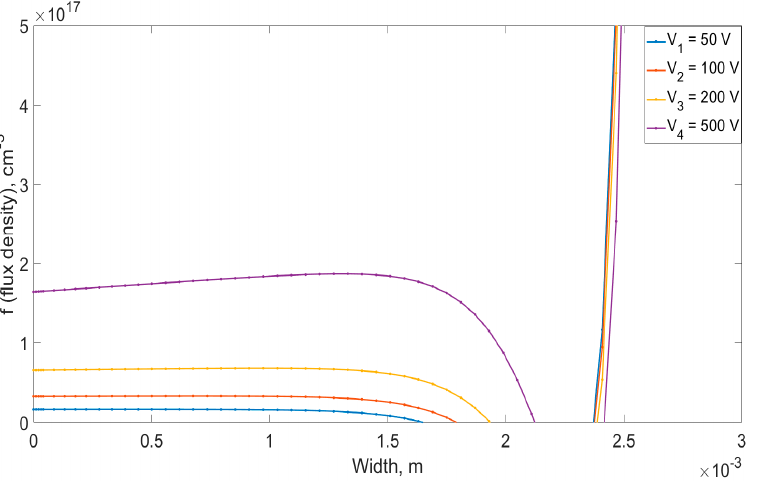
Figure 7. Electric field distribution in the cross-section of the crystal during the double-sided drift process, taking into account the presence of uncompensated lithium-ions.